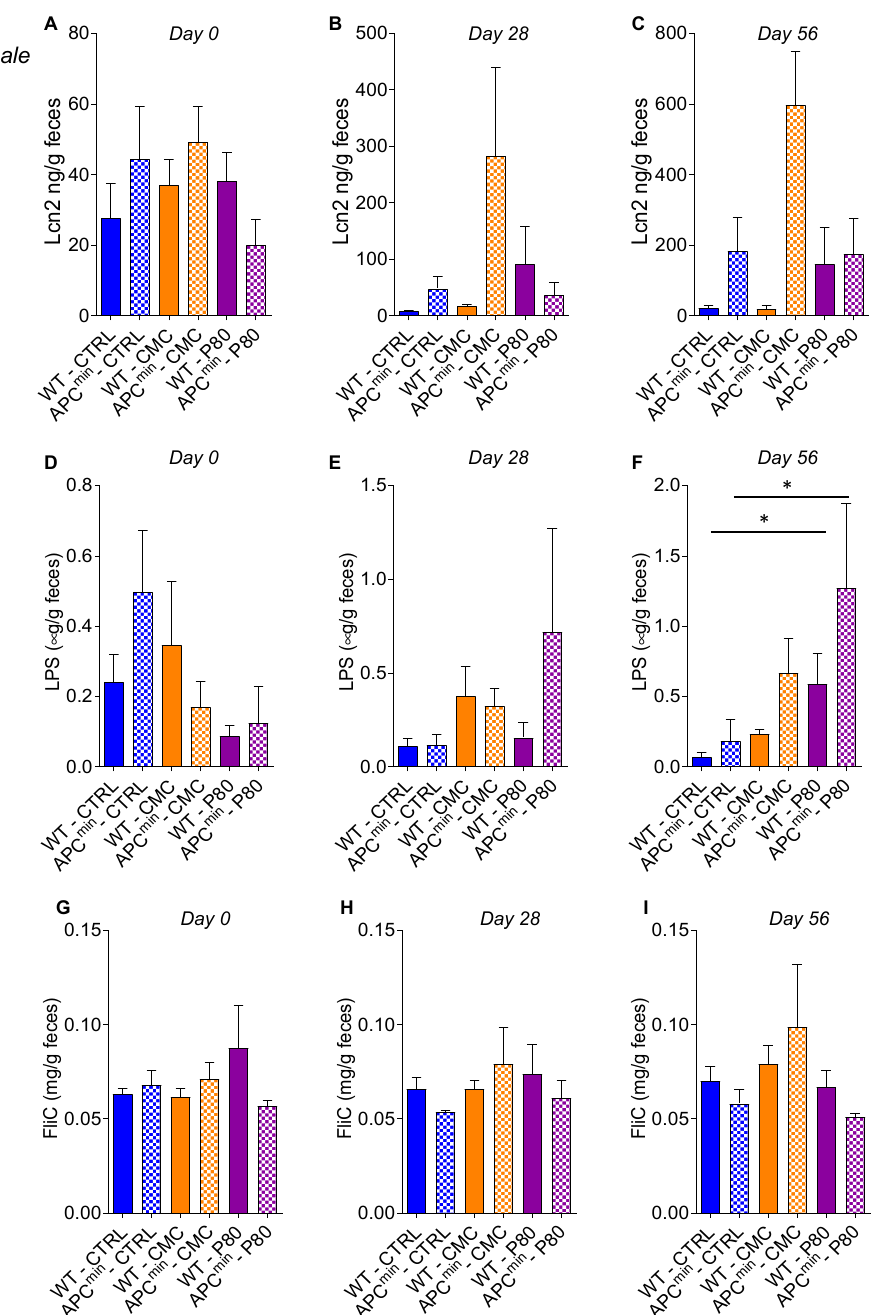
Figure 4. Dietary emulsifier consumption alters the intestinal inflammatory environment in WT and APC min female mice. Seven-week-old WT and APC min female mice were exposed to drinking water containing CMC or P80 (1.0%) for 15 weeks. ( A – C ) Fecal lipocalin-2 (Lcn2) concentration and ( D – F ) bioactive levels of fecal lipopolysaccharide (LPS) and flagellin (FliC) ( G – I ) were assessed at day 0 ( A , D , G ), day 28 ( B , E , H ), and day 56 ( C , F , I ). Data are the means +/ − S.E.M. ( n = 5 for the WT–CTRL group, 3 for the APC min –CTRL group, 7 for the WT–CMC group, 5 for the APC min –CMC group, 6 for the WT–P80 group and 3 for the APC min –P80 group). Significance was determined using one-way group ANOVA with a Bonferroni test (* indicates statistical significance).